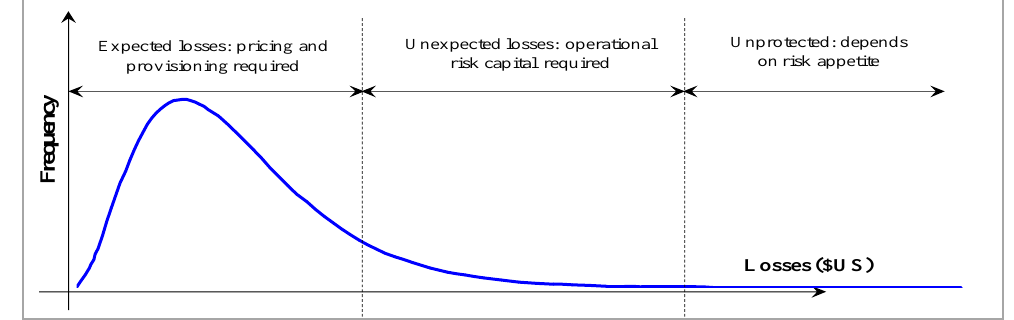
Important features of a typical operational risk loss